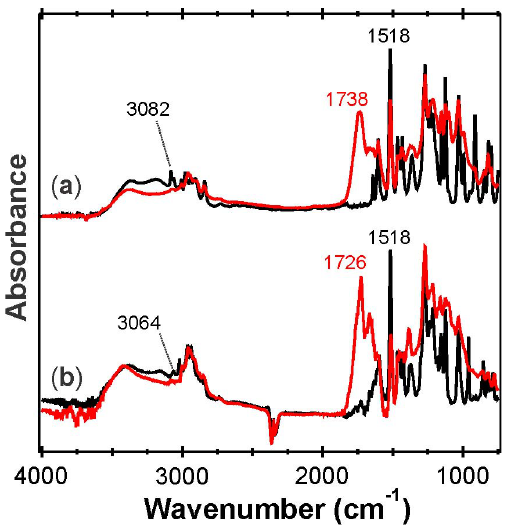
Fig. 6. DRIFTS spectra of (a) eugenol adsorbed on NaCl ex- posed to 424ppb O 3 at t = 0min (black) and 340min (red), and (b) isoeugenol adsorbed on NaCl exposed to 180ppb O 3 at t = 0min (black) and 800min